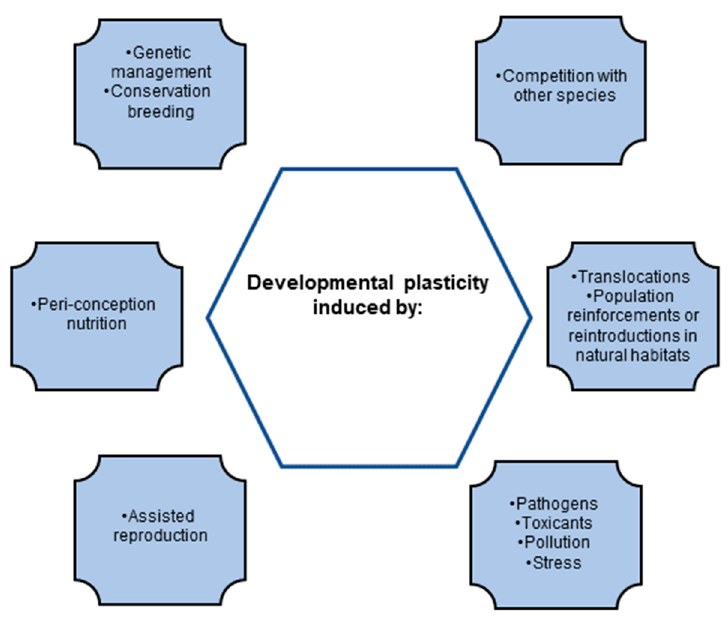
Figure 1. Factors that induce developmental